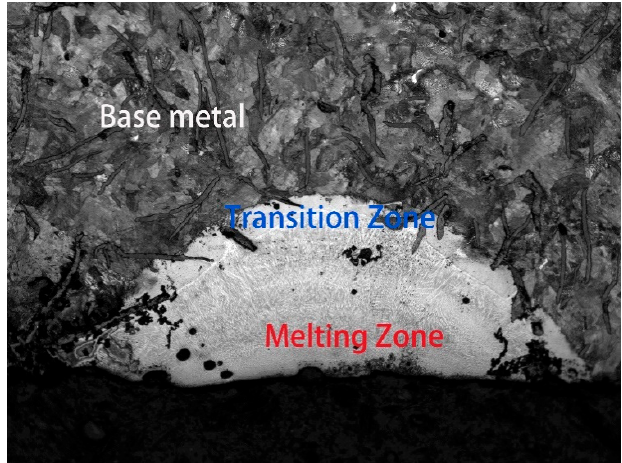
Figure 5. Section microstructure of a biomimetic unit.